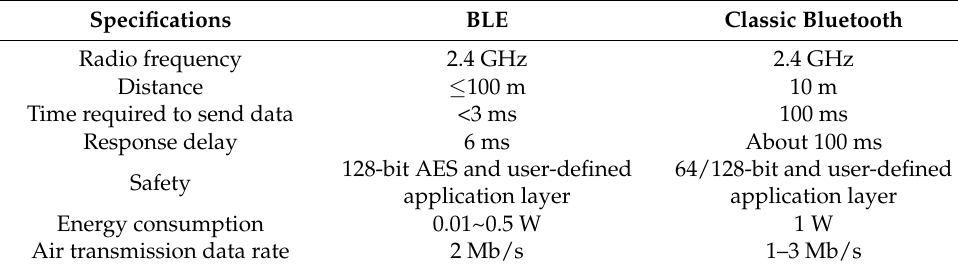
Table 5. The comparative analysis of BLE and classic